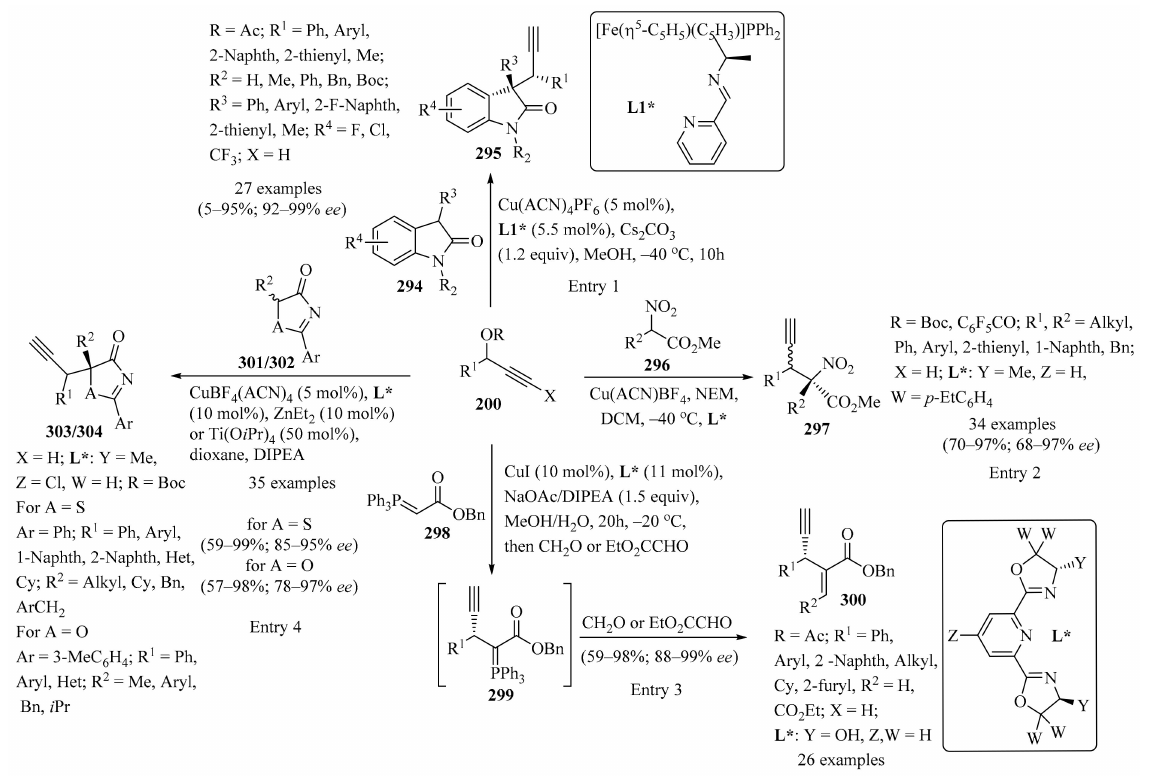
Scheme 96. Efficacy of the copper–ligand complexes in stereoselective α -propargylation of diverse carbonylic/carboxylic compound 294 / 296 / 298 / 301 / 302 with propargyl esters 200